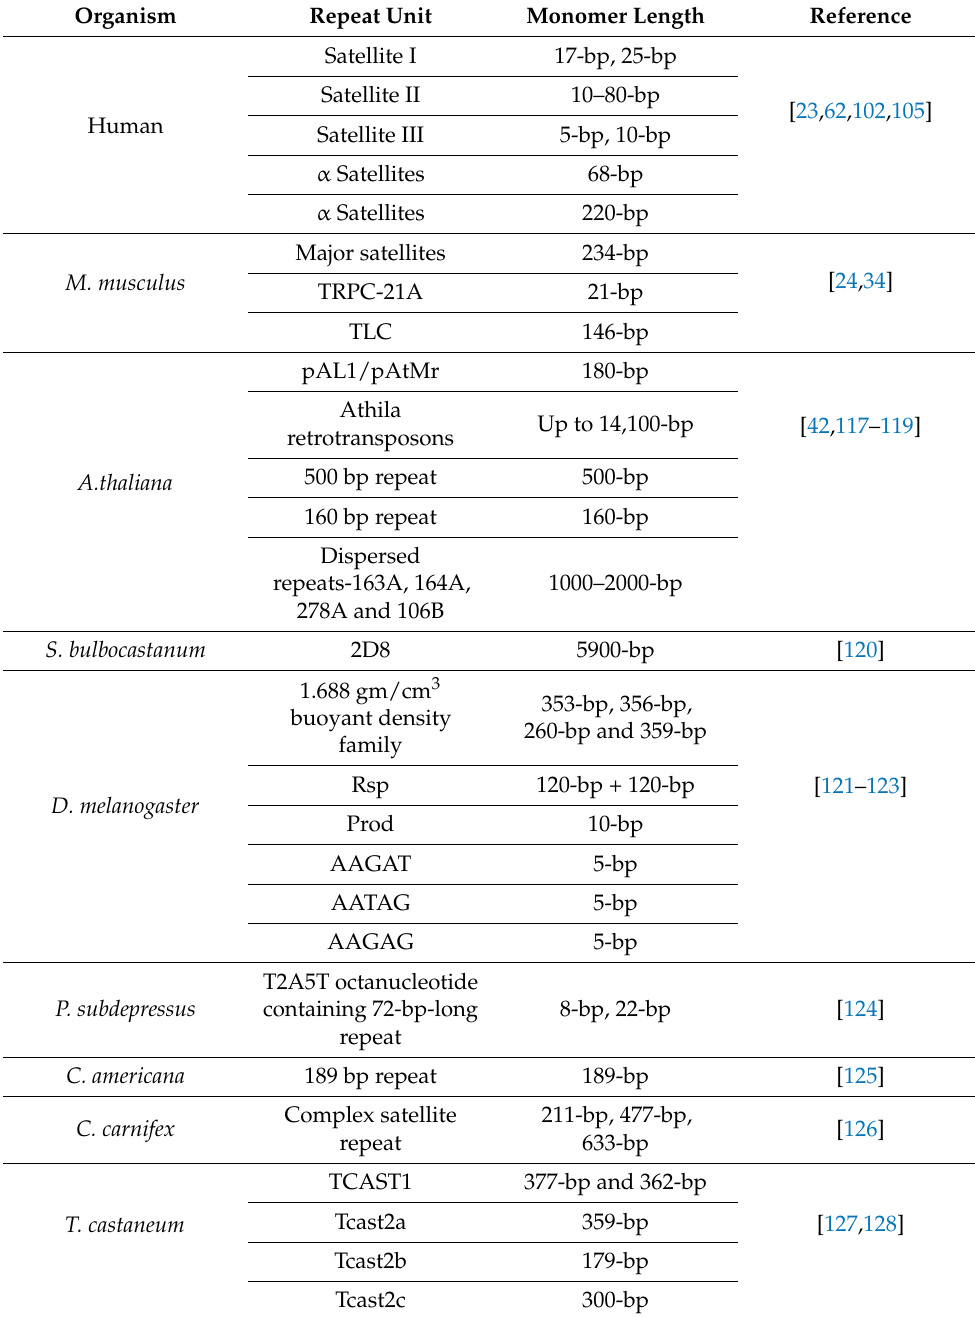
Table 2. Pericentromeric satellite repeat units of mammals, plants and